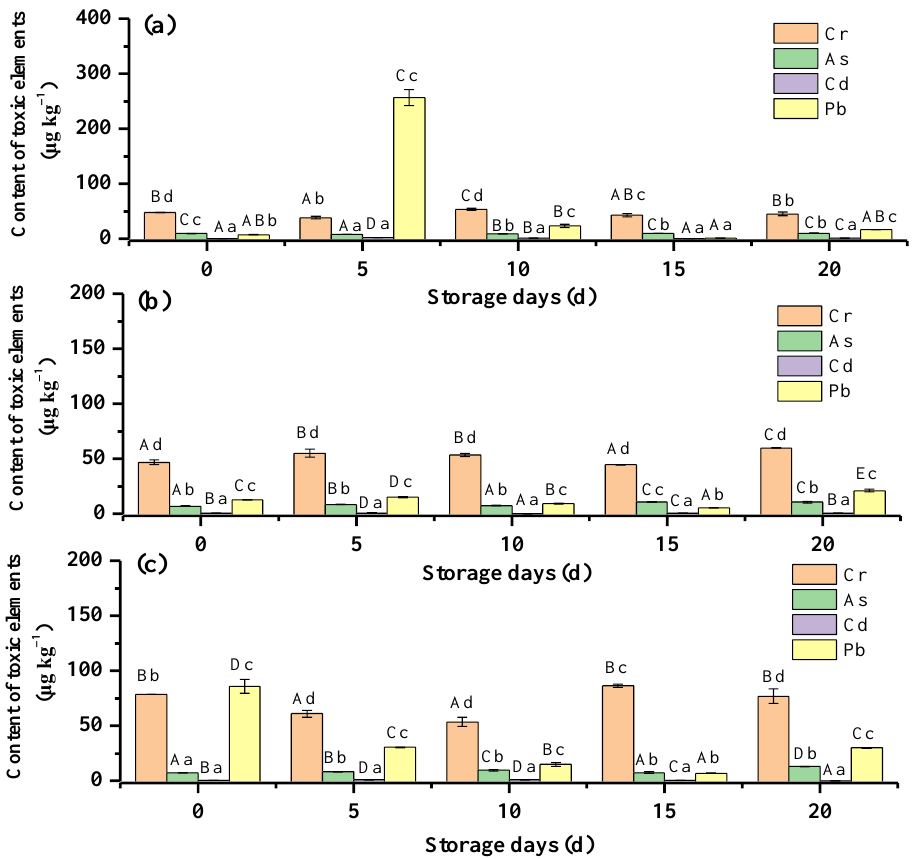
Figure 4. Toxic elements in chicken during storage stage. ( a ) PA + RCPP package, ( b ) PA + PE package, ( c ) PA + aluminum foil + RCPP package. (Capital letters indicate significant differences in the content of the same element in different storage stages. Small letters indicate significant differences in the content of different elements in the same storage stage).